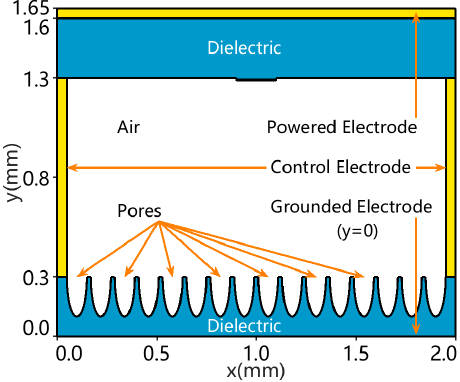
Figure 1. Geometry used in the